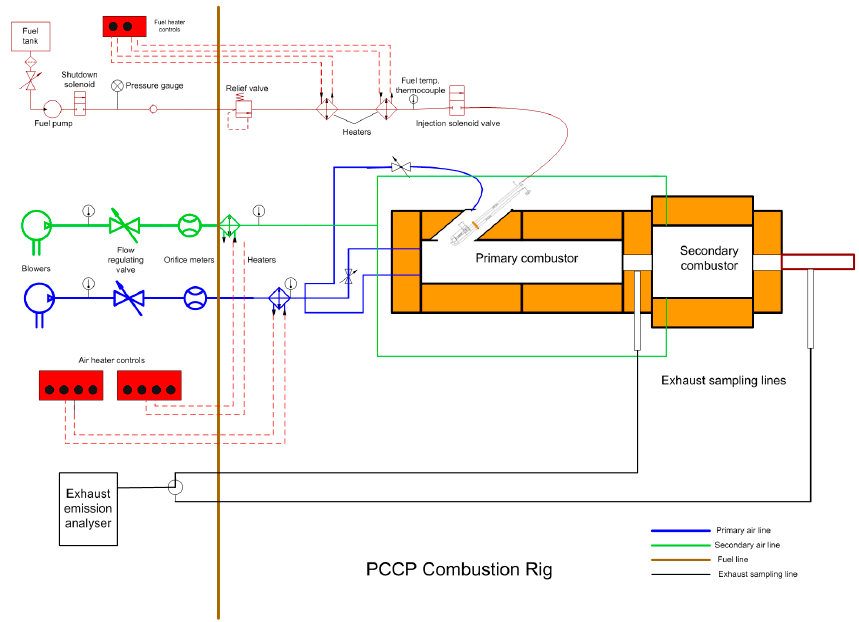
Figure 1. Schematic diagram of the flame visualisation test rig.